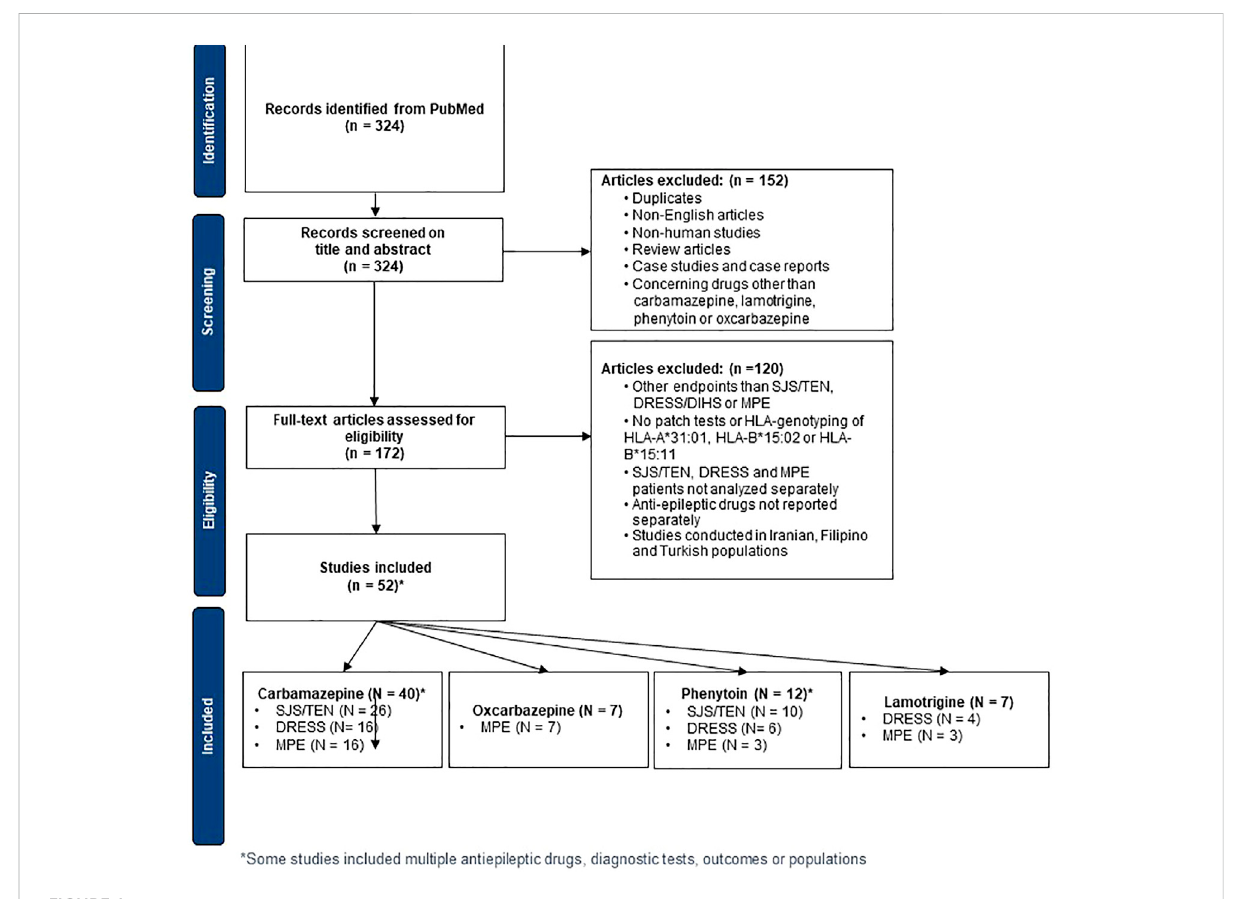
FIGURE 1 Flow Chart of study selection according to inclusion and exclusion